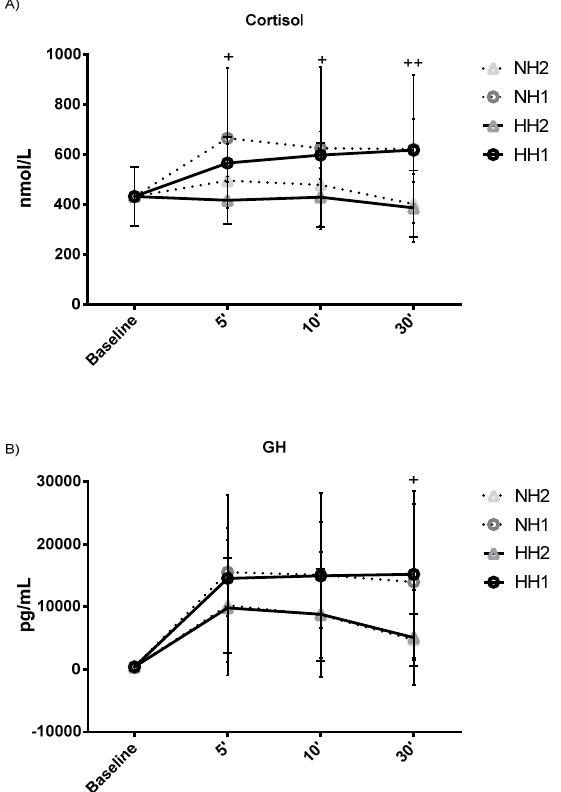
Figure 1. Hormones after resistance training sessions [sub-picture ( A ): cortisol and sub-picture ( B ): GH]. Hypobaric hypoxia (HH) vs. Normobaric hypoxia (NH) with different inter-set rest (1 vs. 2 min). NH2 and NH1: Normobaric Hypoxia with 2-min inter-set rest and 1-min rest. HH2 and HH1: Hypobaric Hypoxia with 2-min inter-set rest and 1-min rest. + p < 0.05, ++ p < 0.01 comparing 1-min inter-set rest vs. 2 min rest over time. No significant differences were observed between HH vs. NH over time.